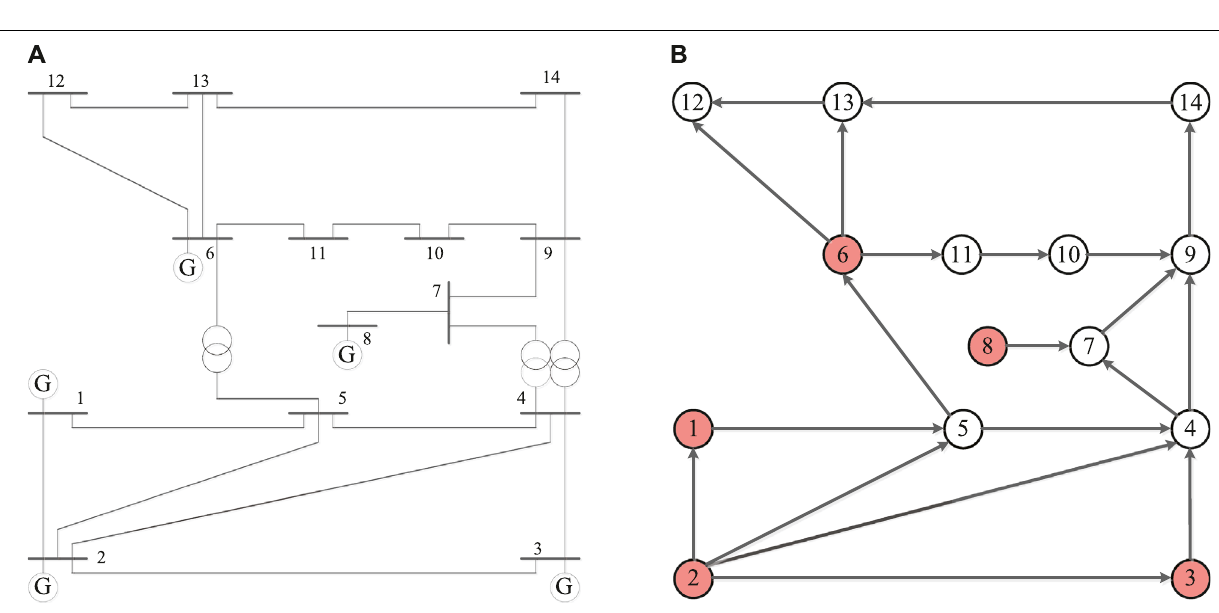
FIGURE 8 | (A) Wiring diagram of IEEE 14 bus system; (B) Network model of IEEE 14 bus system. The red nodes are generator